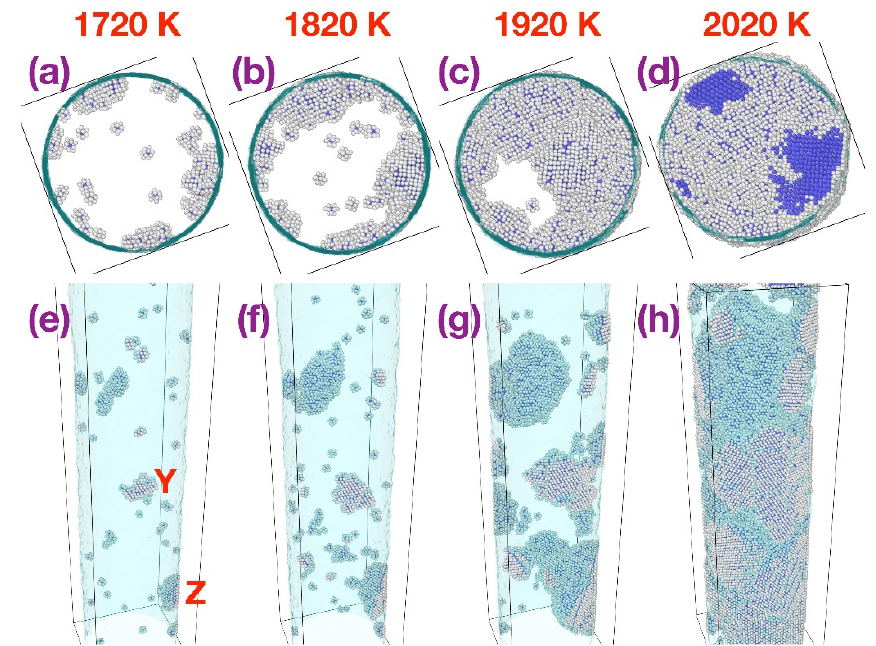
Figure 6. Spatial distribution of BCC (blue colored) and BCC shell (gray colored) atoms in the 10 nm diameter MG nanorod at different temperatures during the simulated heating process. The matrix (supercooled liquid) atoms are made invisible. Upper row ( a – d ): top view (orthogonal projection). Lower row ( e – h ): side view (perspective projection). The two grains labelled as “Y” and “Z” are discussed in the text.